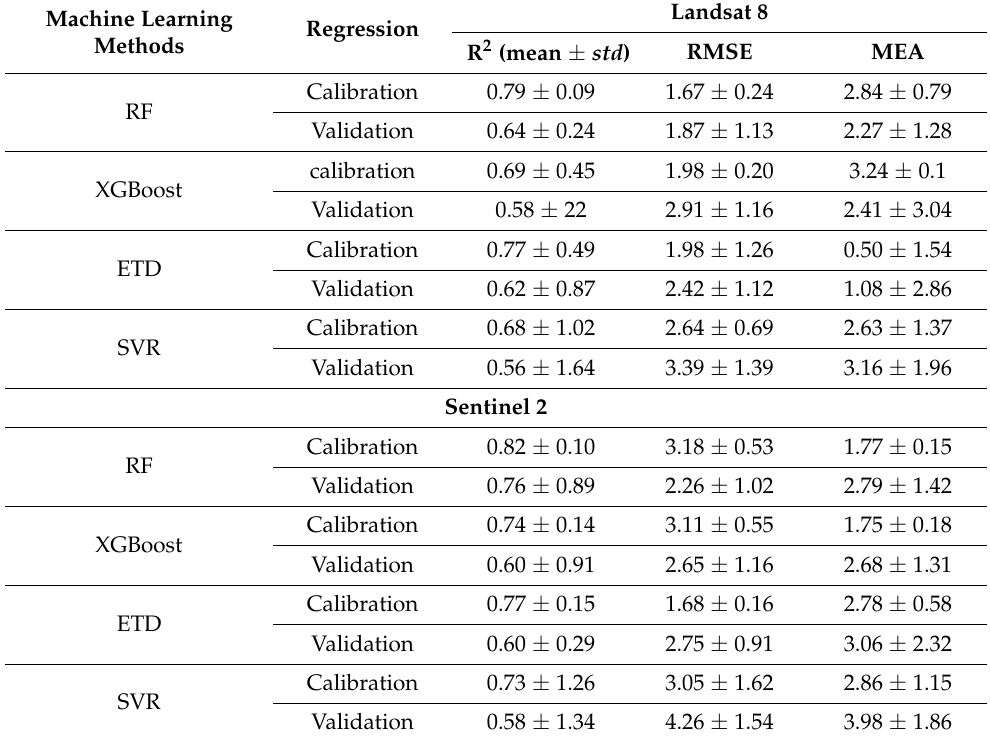
Table 10. Uncertainty with k-fold cross-validation. Machine